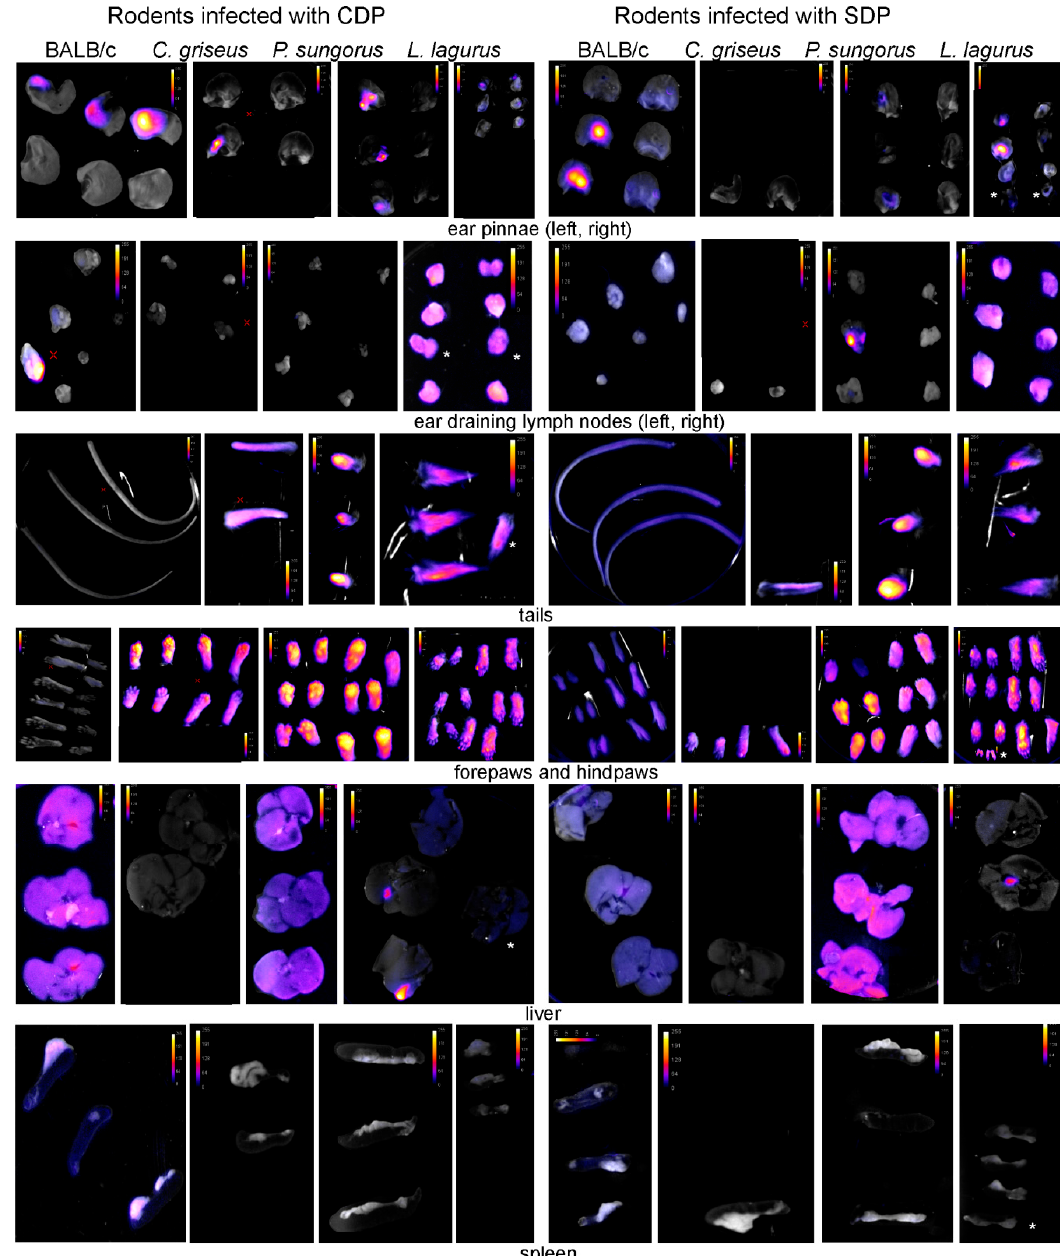
Figure A2. Tissues of infected rodents photographed with In Vivo Xtreme optical display post-mortem during the second run of the experiments. Asterisks indicate control animals.